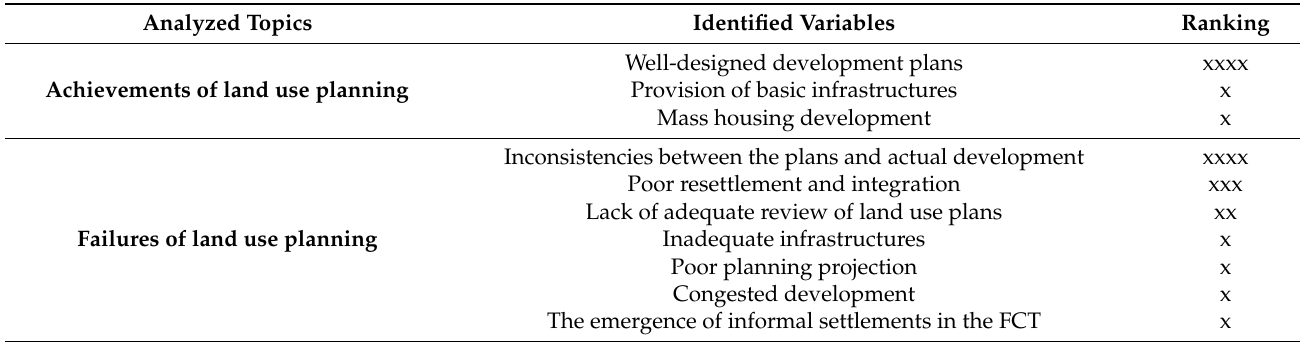
Table 5. The achievements and failures of land use planning based on a survey of